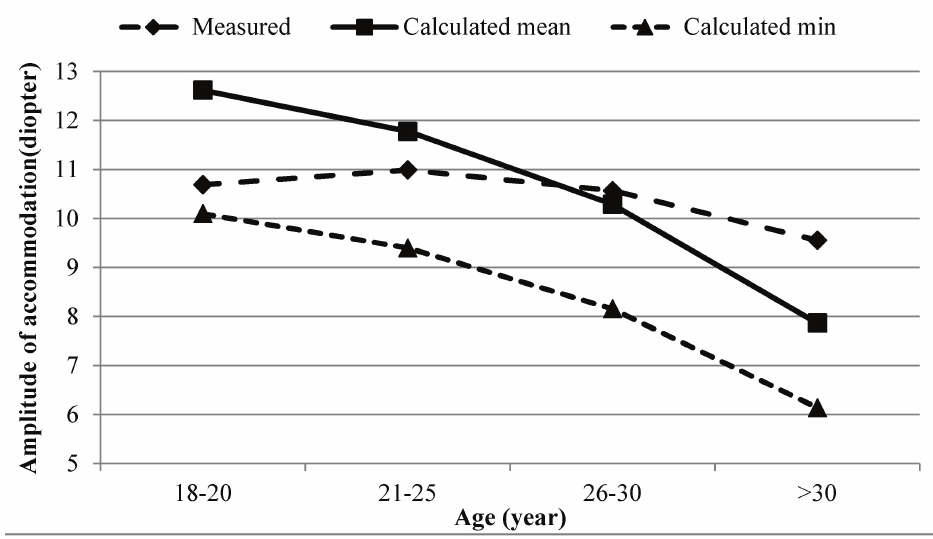
Figure 3. The mean and minimum amplitudes of accommodation calculated by Hofstetter’s formula according to age and mean amplitude of accommodation measured in the present